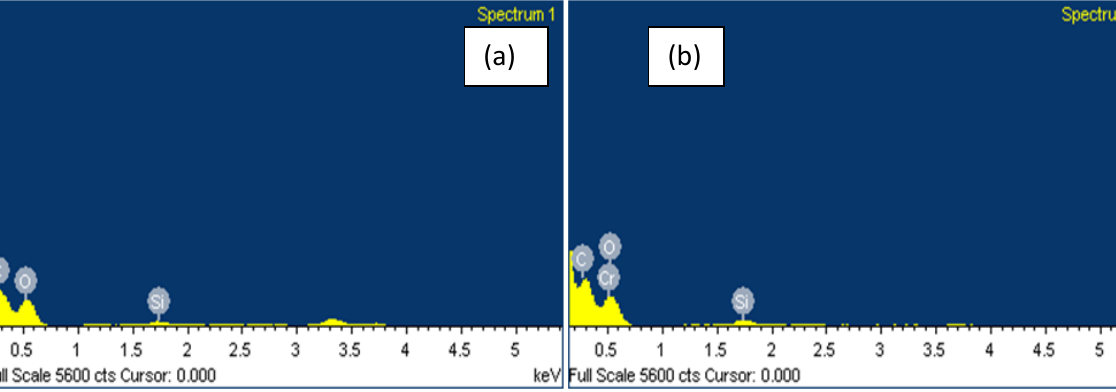
Figure 3. Energy Disperse Spectra of mixed adsorbent (a) before chromium (VI) adsorption (b) after chromium (VI)